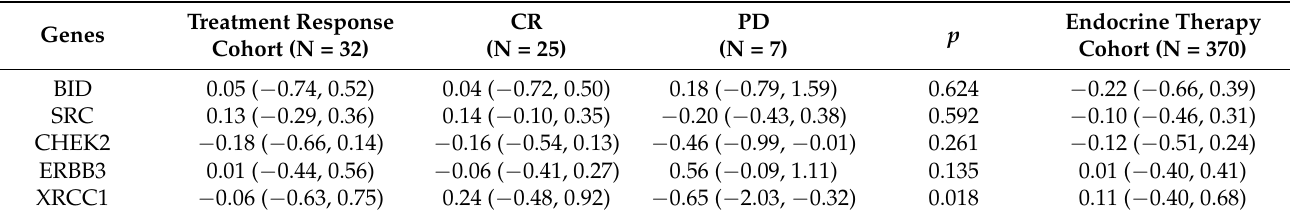
Table 7. The RPPA expression of candidate genes in the treatment response and endocrine therapy